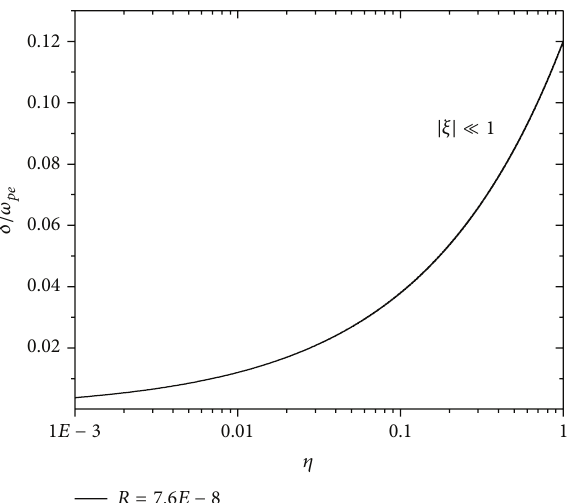
Figure 3: The normalized growth rate of the Weibel instability, 𝛿/𝜔 𝑝𝑒 , as a function of density gradient, 𝜂 , for the fixed quantum parameter V 𝑅 = ℏ𝑘/2𝑚 𝑒 𝑡‖